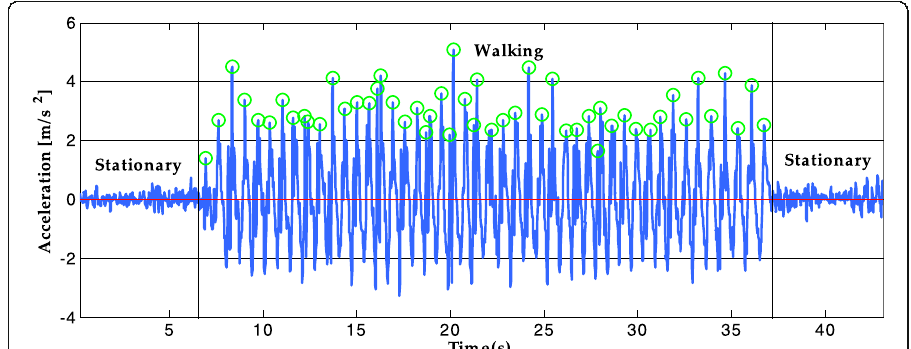
Fig. 3 The acceleration patterns of a pedestrian in stationary and walking